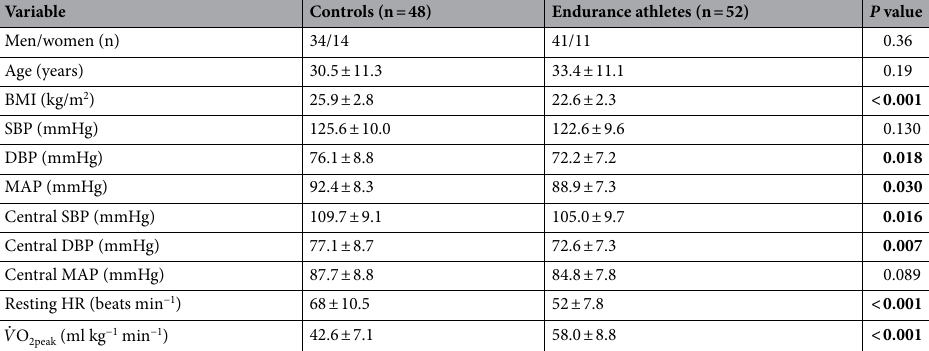
˙ V O 2peak , maximal aerobic